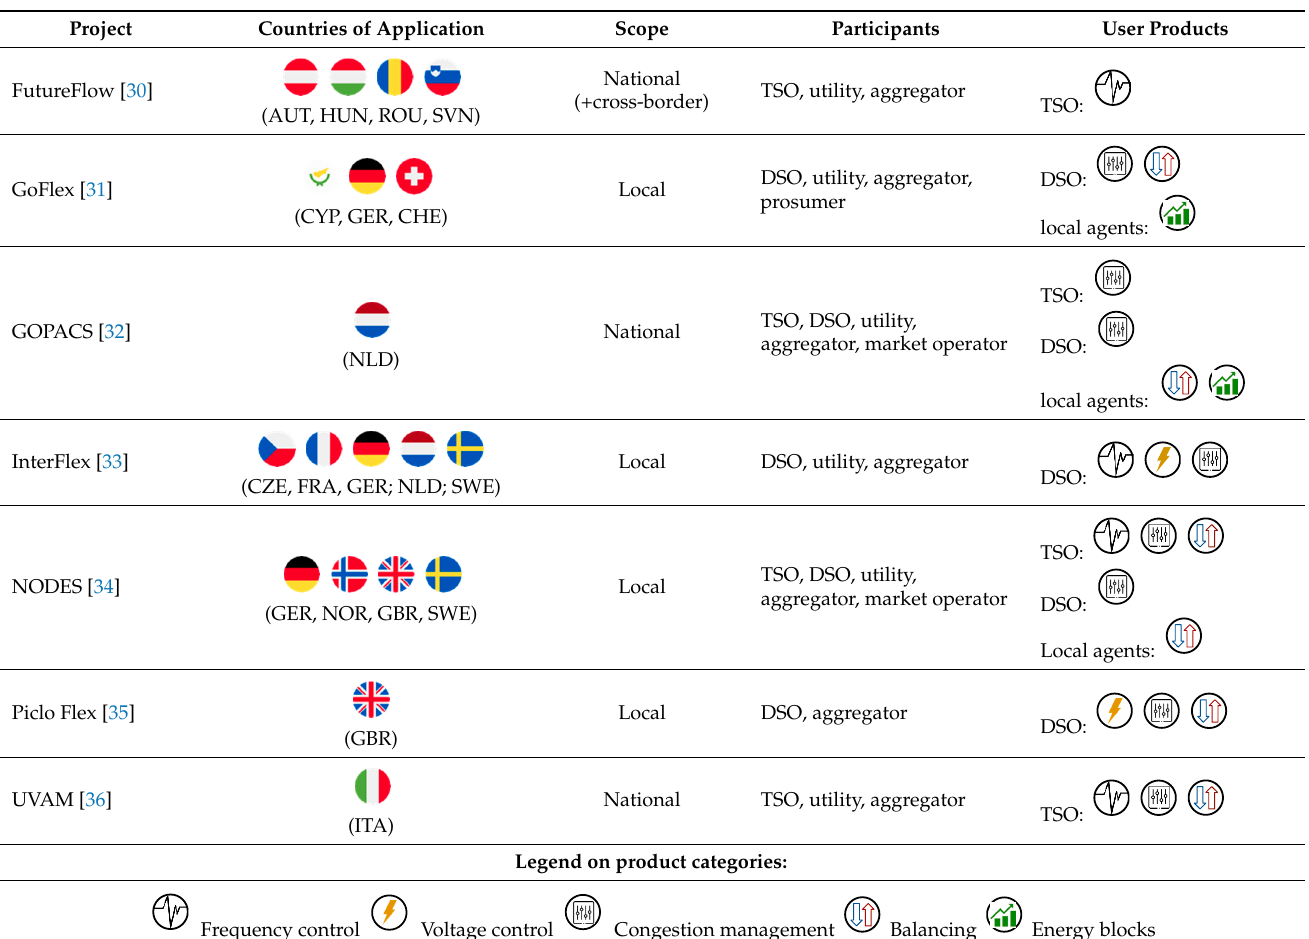
Table 1. Key facts on selected European pilot projects for market integration of flexibility from decentralized energy re- sources (DERs) (not exhaustive).